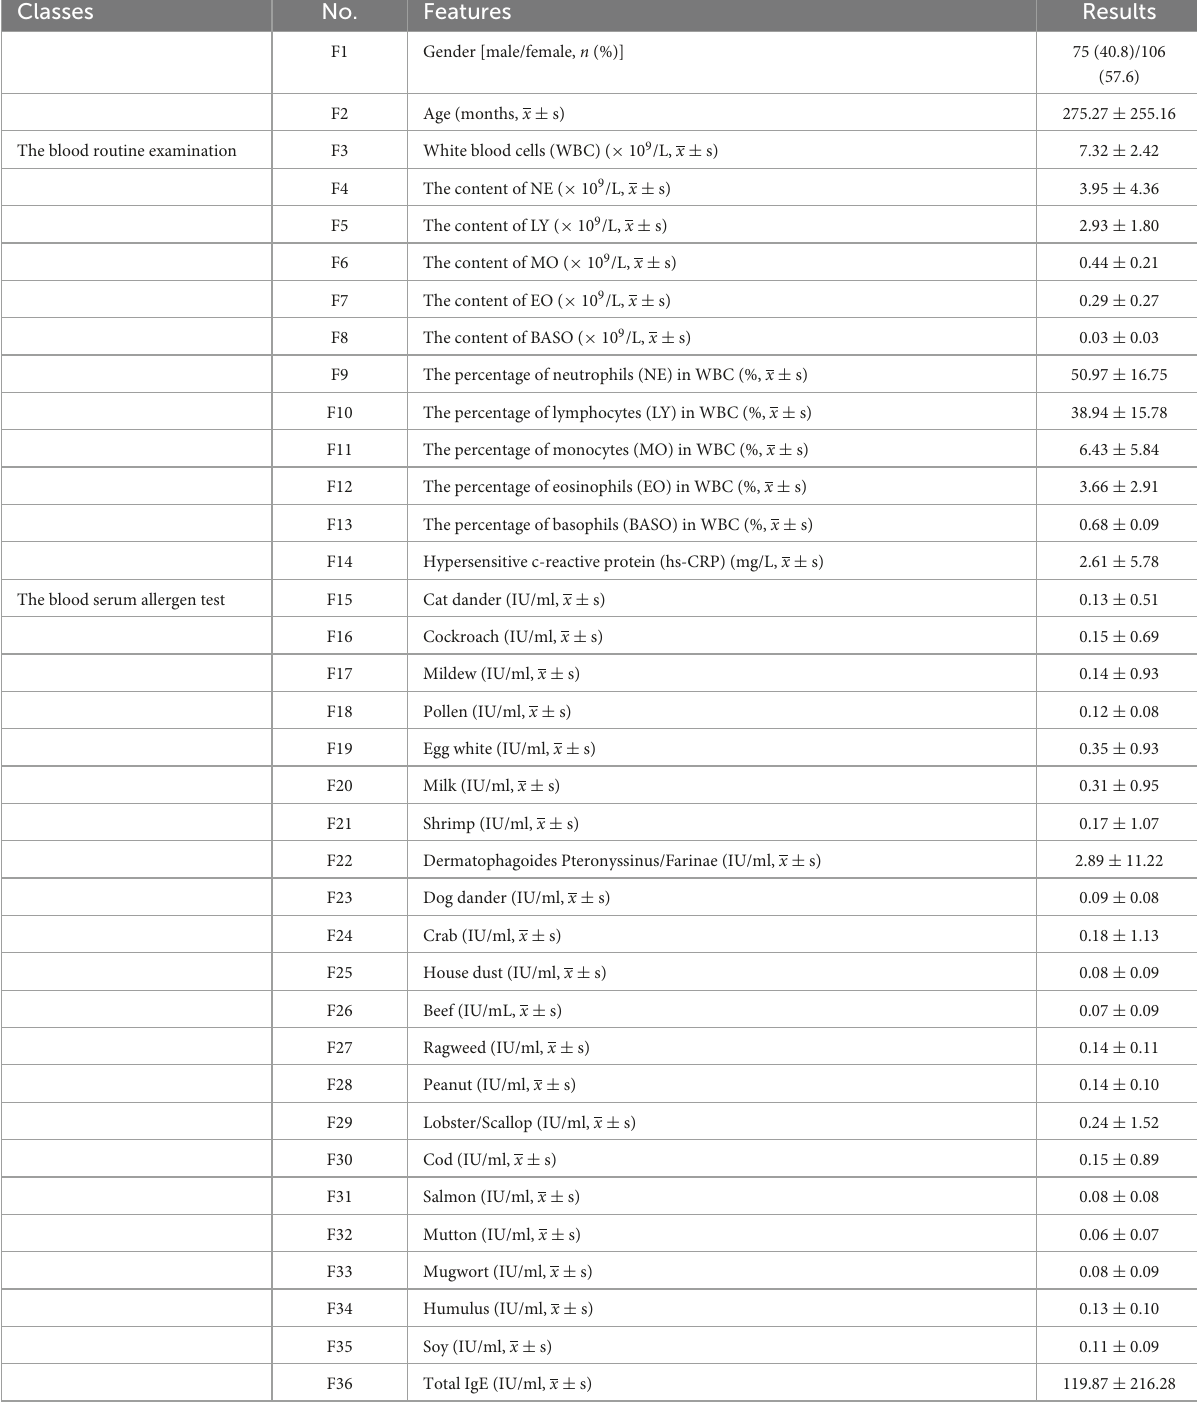
TABLE 21 The characteristics dataset of 181 patients with